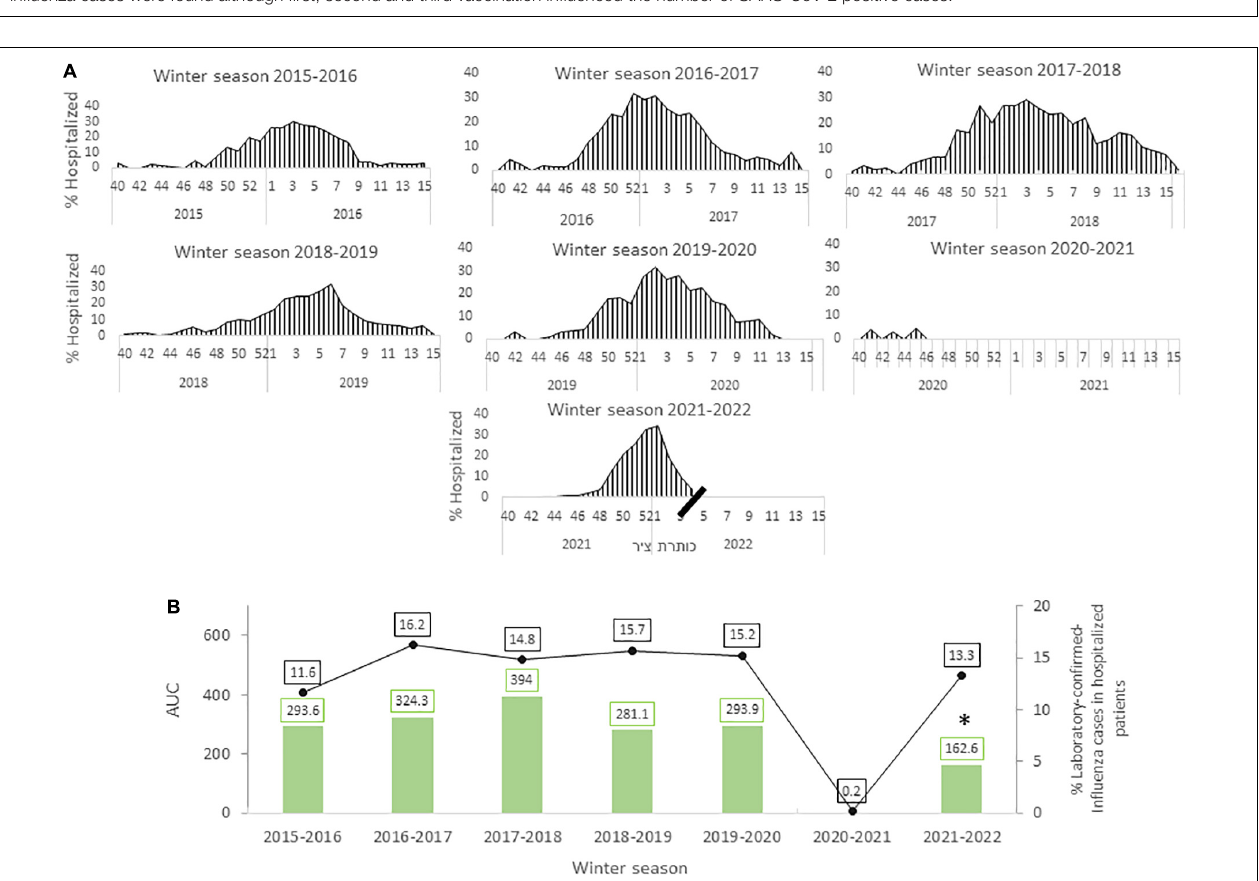
FIGURE 1 | Incidence of influenza subtypes in winter 2019-2020, before and during the SARS-CoV-2 pandemic. After SARS-CoV-2 emerged in 2020, almost no influenza cases were found although first, second and third vaccination influenced the number of SARS-CoV-2 positive cases.